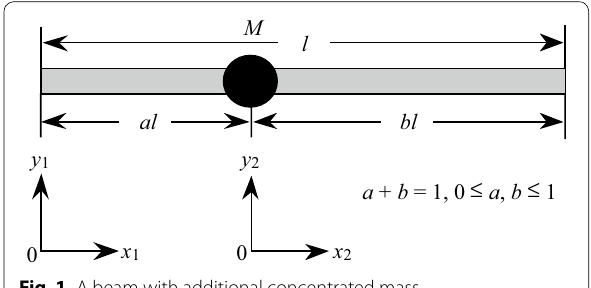
Fig. 1 A beam with additional concentrated